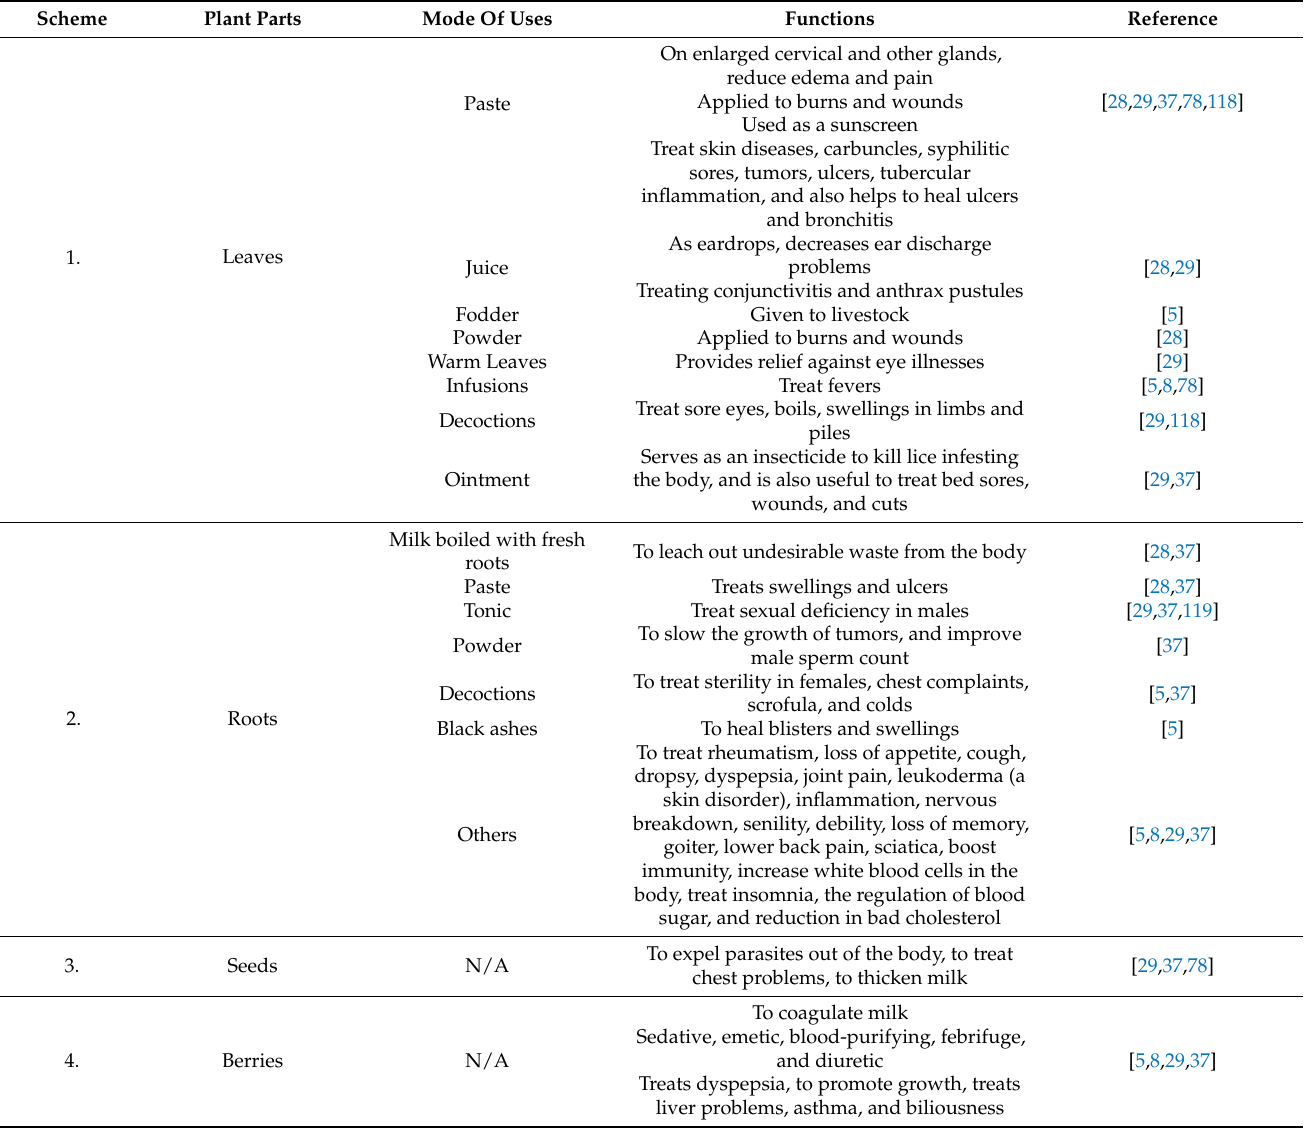
Table 7. Various modes of uses of different parts of